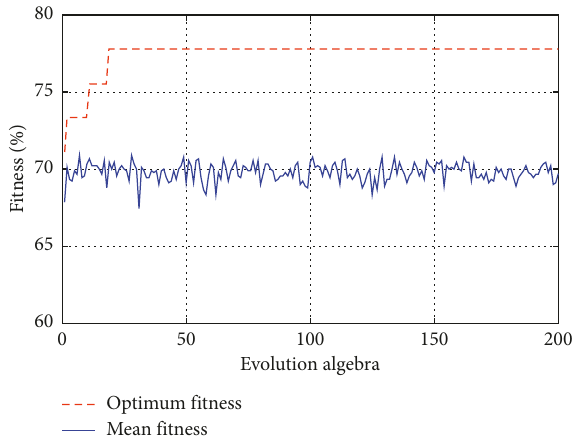
Figure 8: Experimental results of the SVD value and Hilbert marginal spectrum as